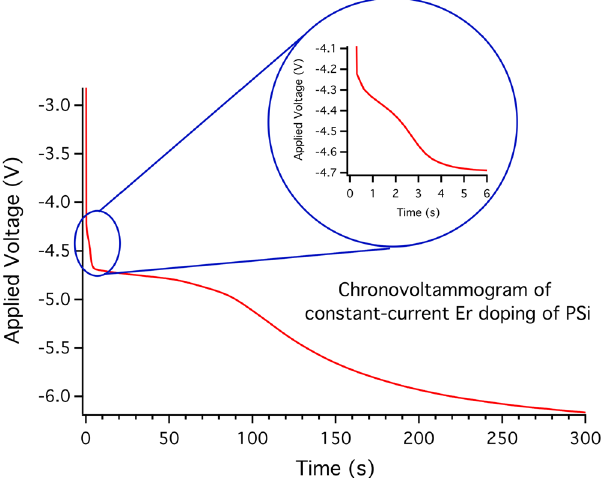
Figure 1. Evolution of the applied voltage during EI of PSi. A typical evolution of the voltage during a constant-current EI process for the insertion of Er into the PSi matrix is shown. The presence of several phases is evidenced by its non-constant behavior. In the inset, an enlargement of the double transient observed in the initial phases of the infiltration process is